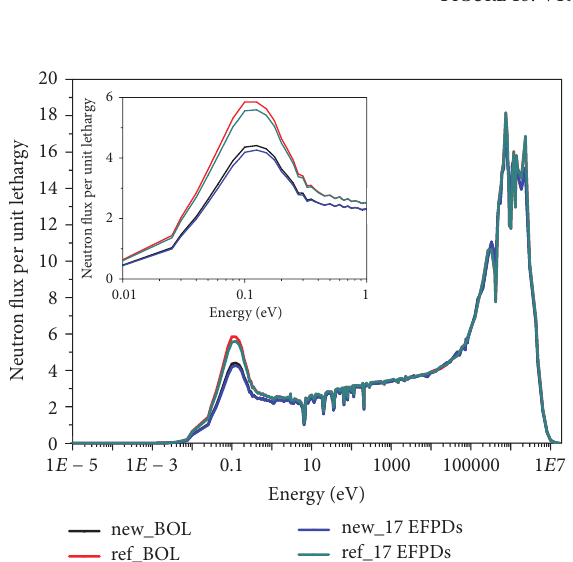
Figure 16: VRC for 5% and 50% void.